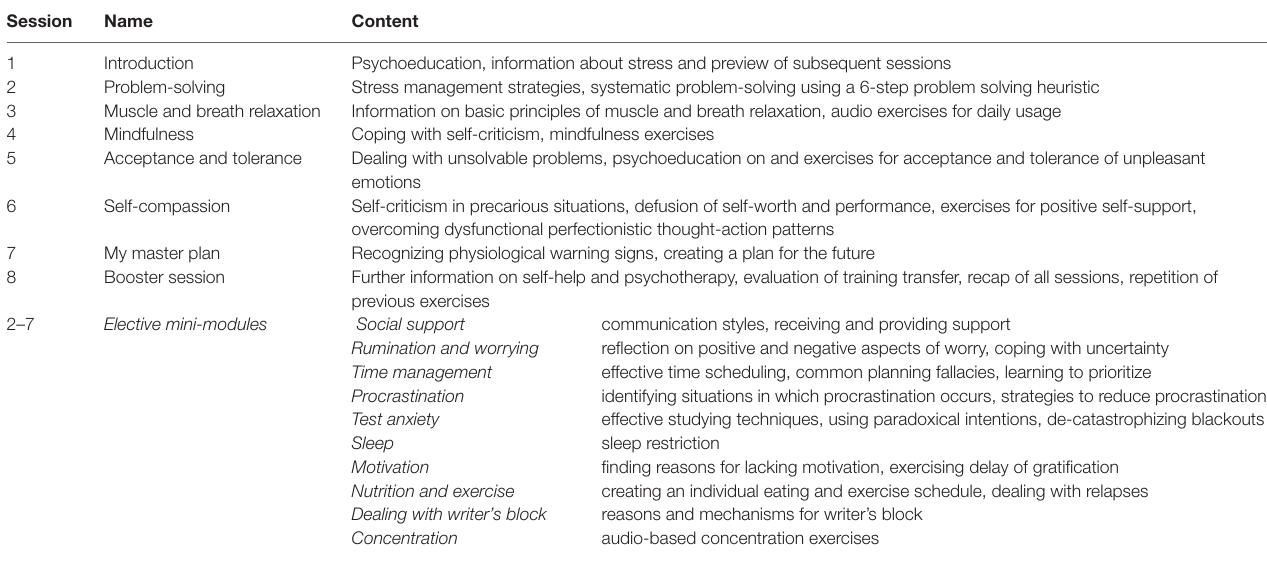
TABLE 1 | Modules of the intervention (StudiCare